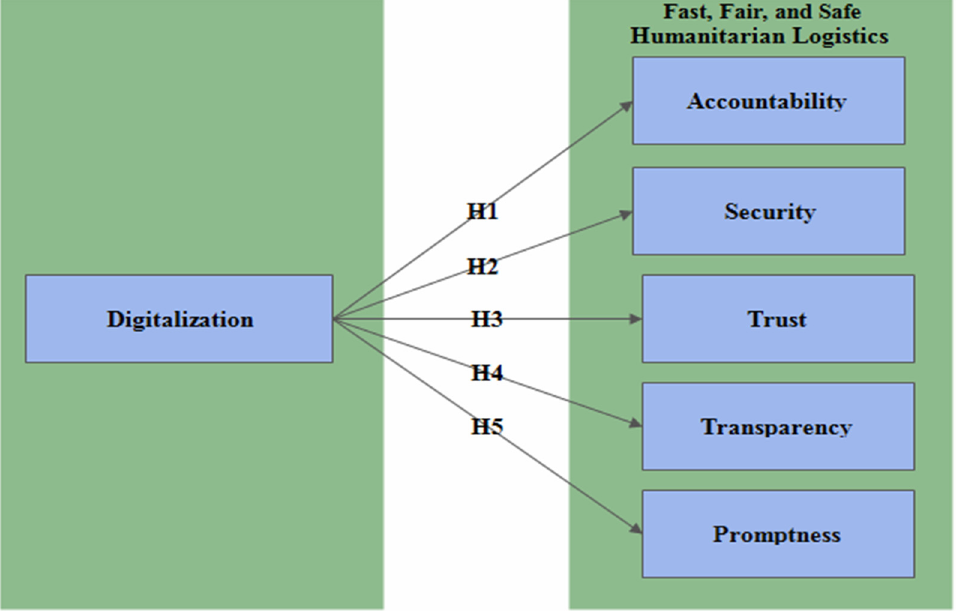
Figure 1. The Research Model’s Framework.